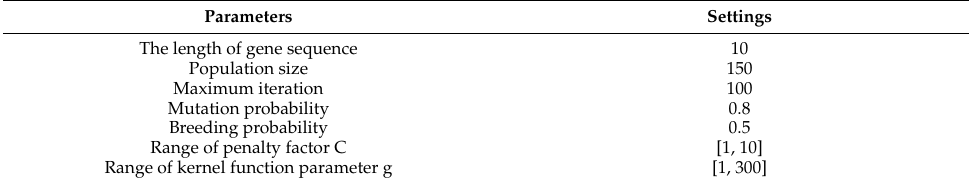
Table 5. The detailed parameter settings of GA.